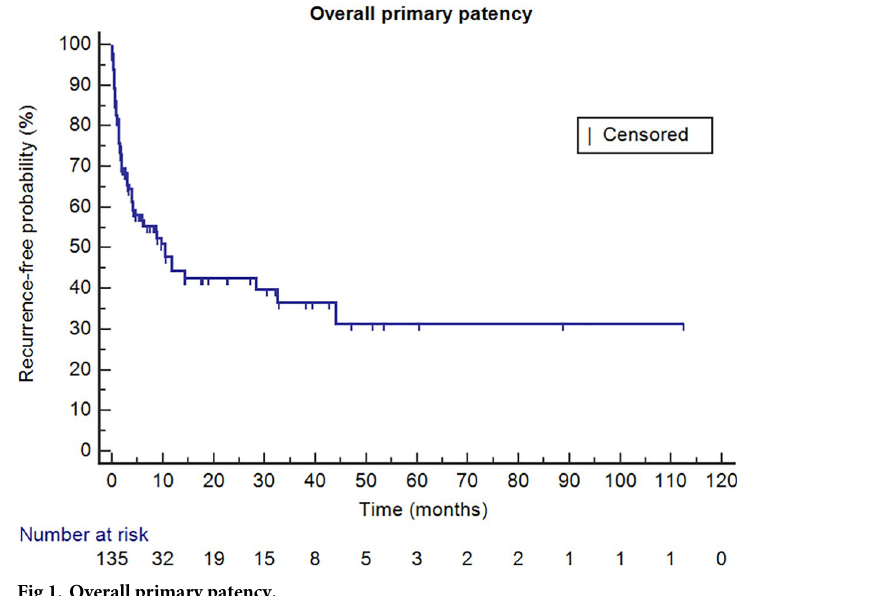
Fig 1. Overall primary